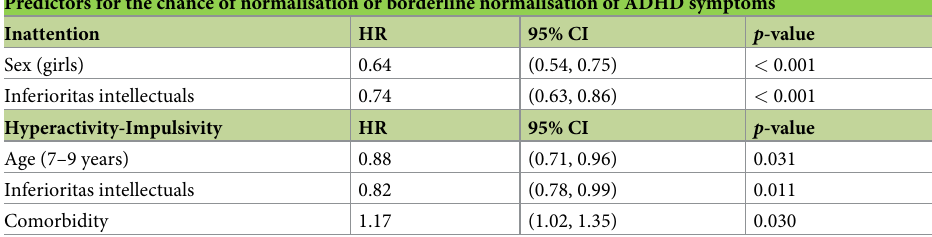
Table 4. Baseline characteristics as predictors for the chance of normalisation or borderline normalisation of the clinician rated ADHD core symptoms score ( n = 207). Predictors for the chance of normalisation or borderline normalisation of ADHD symptoms